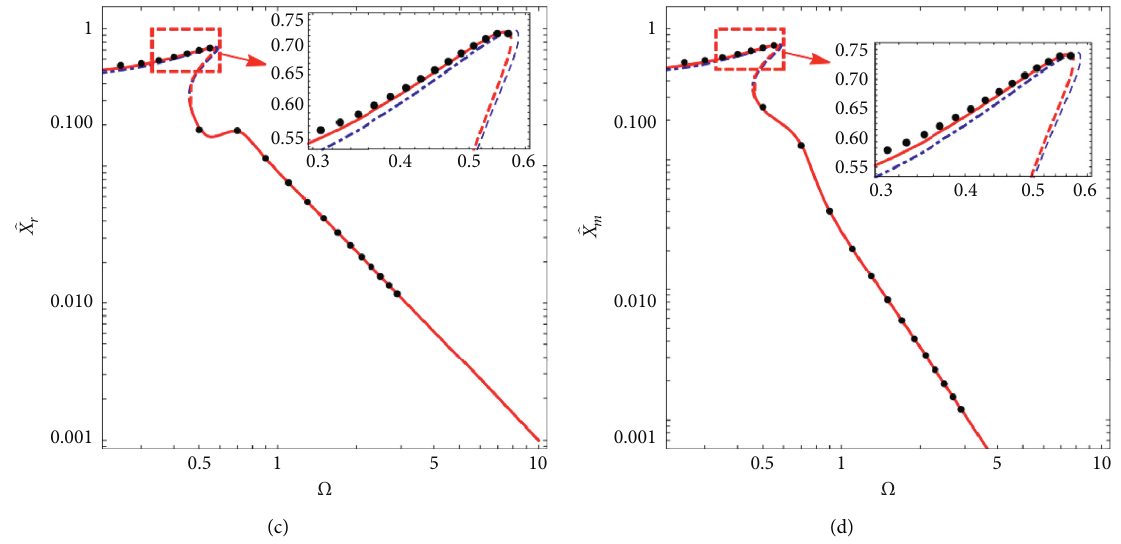
Figure 6: (a) and (c) are amplitude-frequency curves of the relative displacement between m frequency curves of m s 2 , when μ � 0 . 2, (a-b) ζ v k k � k k � 7/6, 􏽢 l � 0 . 7, and 􏽢 F h 1 / v 1 h 2 / v 1 solution by the HBM1; solid line , stable solution by the EHBM; thick-dashed line , unstable solution by the EHBM; dot , numerical results.